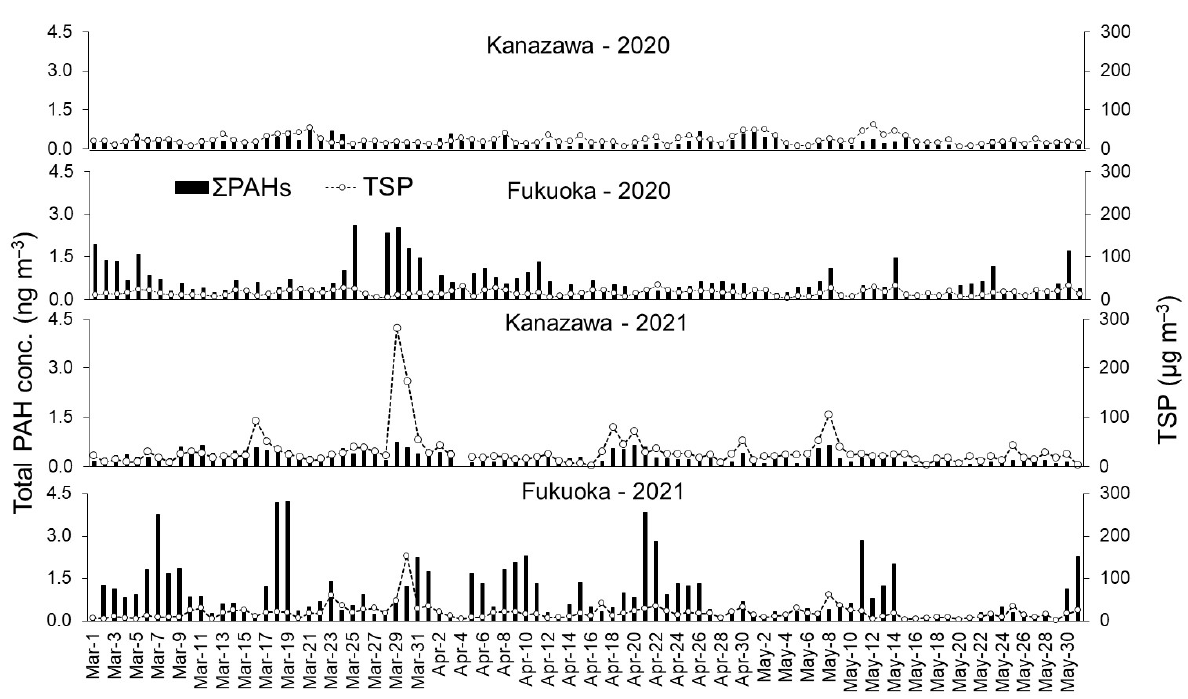
Figure 2. The concentrations of total PAH (ng m − 3 ) and TSP ( µ g m − 3 ) from March to May in 2020 and 2021 in Fukuoka and Kanazawa.